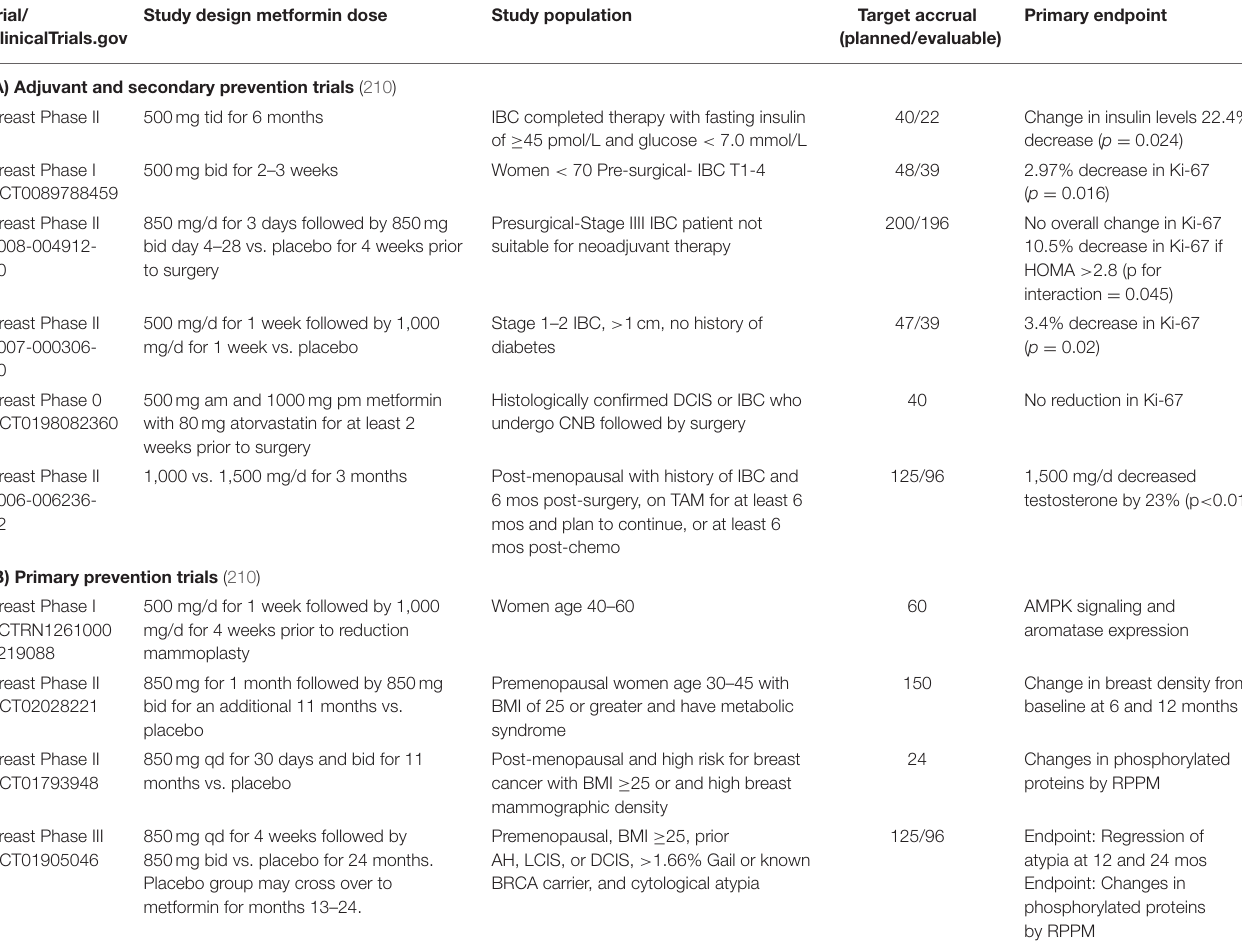
TABLE 3 | Adjuvant, secondary prevention, and primary prevention trials utilizing metformin. Trial/ Study design metformin dose Study ClinicalTrials.gov